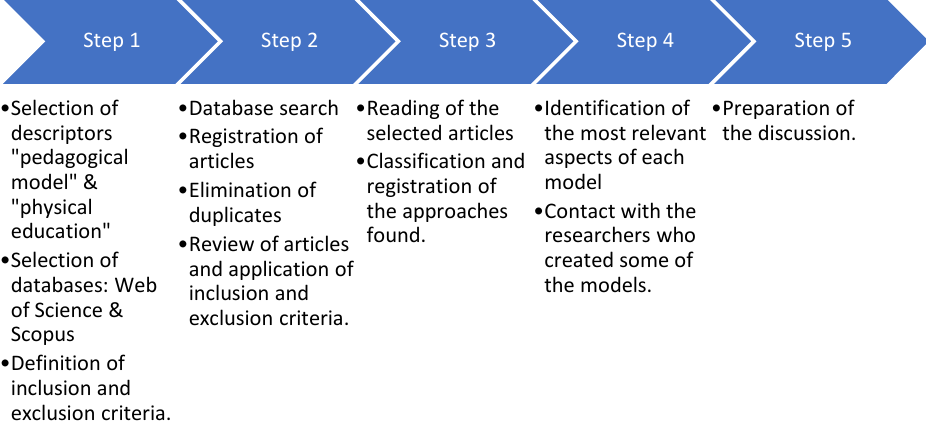
Figure 3. Information search process .